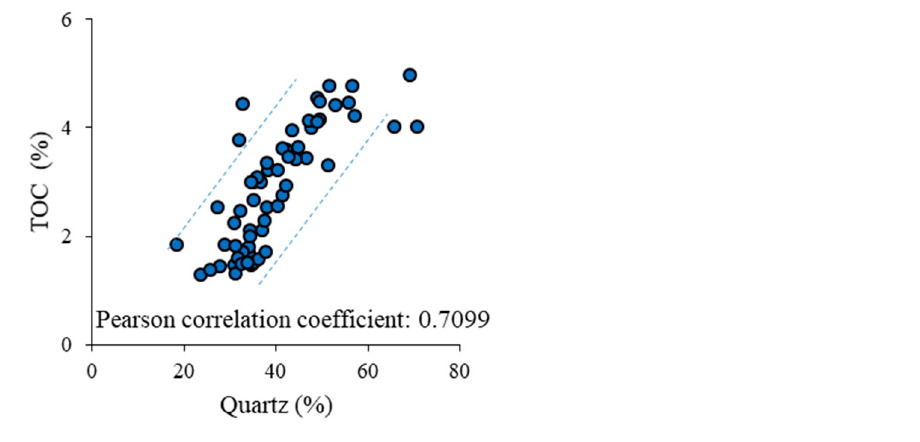
Figure 4. Scatter plot of total organic carbon (TOC) and quartz content in Wufeng-Longmaxi Formation from Well A. Table 3. Classification standards of lithofacies.